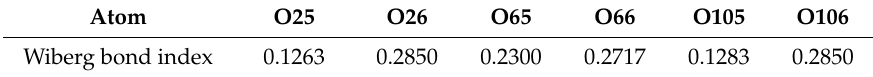
Table 1. Calculated Wiberg bond indexes between the indicated oxygen atoms and the Cu 2 + .